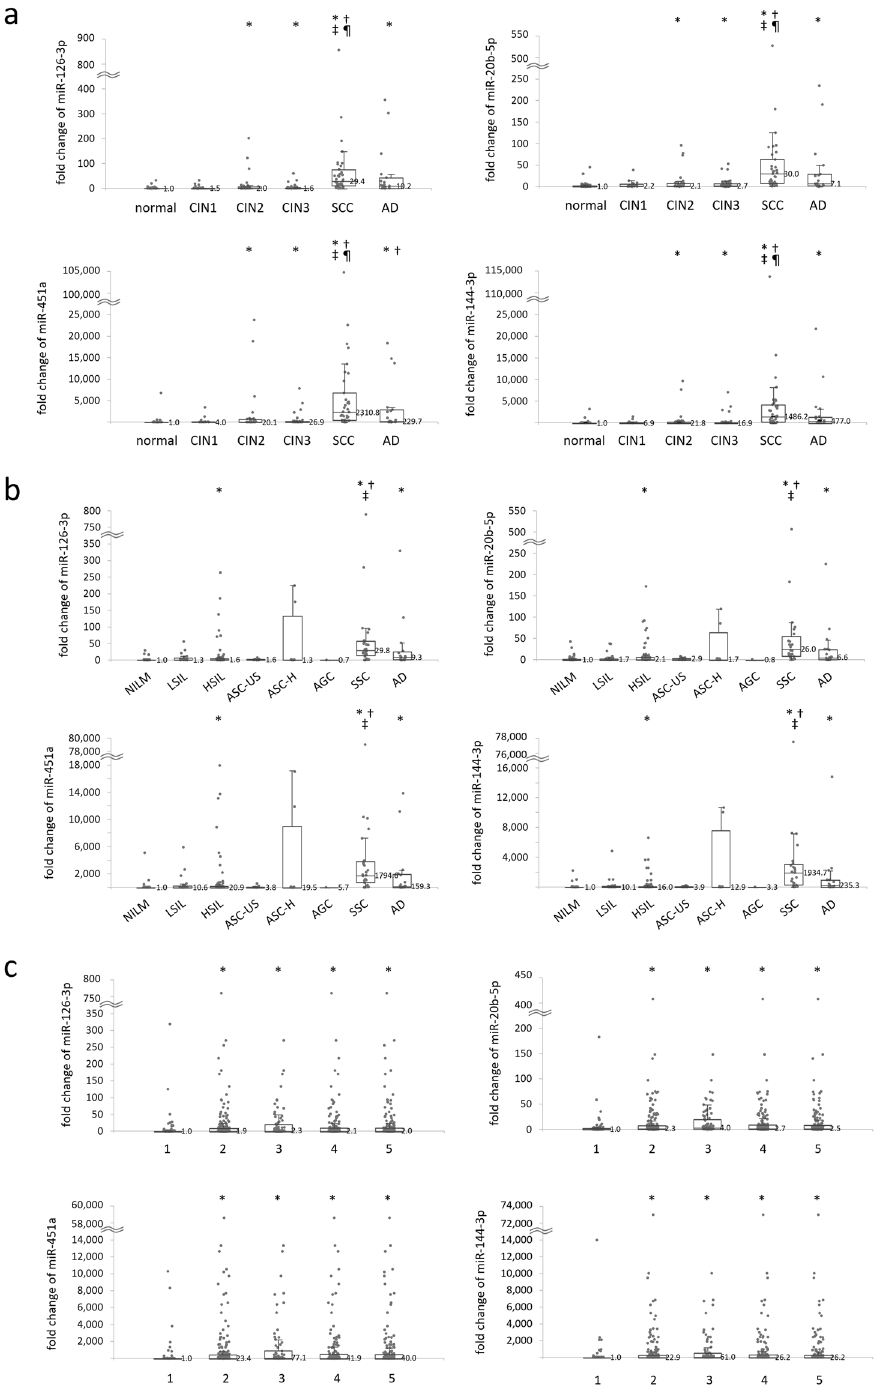
Figure 2. The expression levels of four miRNAs by real-time RT-PCR were correlated with histology ( a ), cytology ( b ) and HPV genotype ( c ) in the real-time RT-PCR cohort. The expression level was corrected against the mean value of the expression level in the normal group ( a ), NILM ( b ) and negative group ( c ). The median value in each group is depicted in the graph. The corrected value of the expression level is indicated on the y-axis and the histology ( a ), cytology ( b ) and the HPV status ( c ) are indicated on the x-axis. ( a ) CIN: cervical intraepithelial neoplasia, SCC: squamous cell carcinoma, AD: adenocarcinoma. The value of these miRNAs significantly increased with the severity of the disease, such as normal, CIN1, 2, 3, and SCC as determined by the Jonckheere–Terpstra trend test. There was a significant difference between normal and CIN2 + as determined by the Kruskal–Wallis test and the Mann–Whitney U test with a Bonferroni correction for all four miRNAs. * P < 0.05 vs normal, † P < 0.05 vs CIN1, ‡ P < 0.05 vs CIN2, ¶ P < 0.05 vs CIN3. ( b ) NILM: negative for intraepithelial lesion or malignancy; LSIL: low-grade squamous intraepithelial lesion; HSIL: high-grade squamous intraepithelial lesion; ASC-US: atypical squamous cells of undetermined significance;